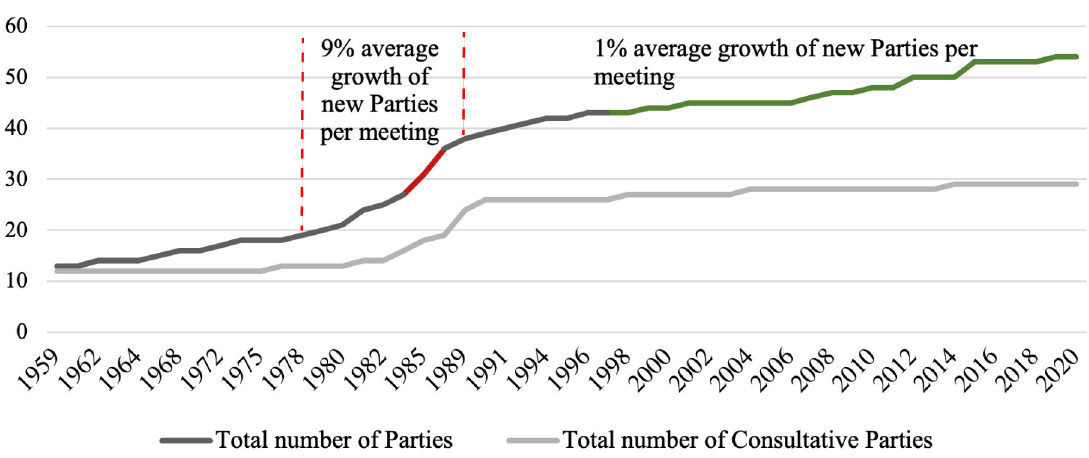
Figure 2. Membership growth of Parties and Consultative Parties in total numbers from 1959 to